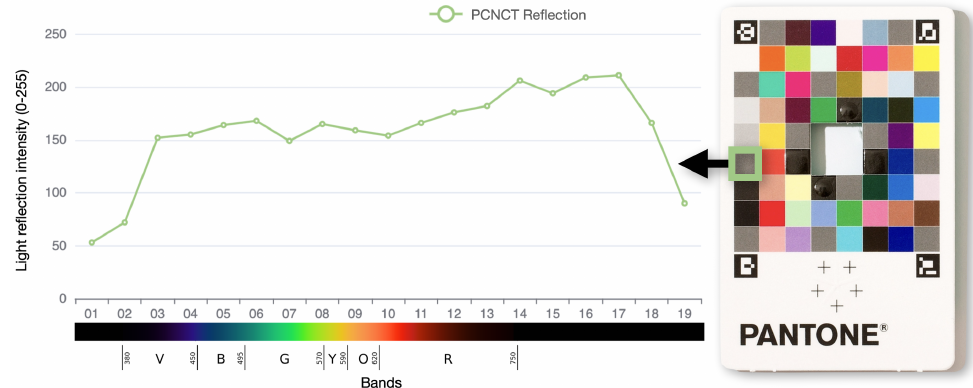
Figure 5. The light intensity of reflection on the PCNCT. The intensity of reflections across different wavelengths on the Pantone Color Match Card (PCNCT). The X-axis refers to the number of bands and wavelengths, the Y-axis represents the reflection intensity of the light from PCNCT (normalized to [0,